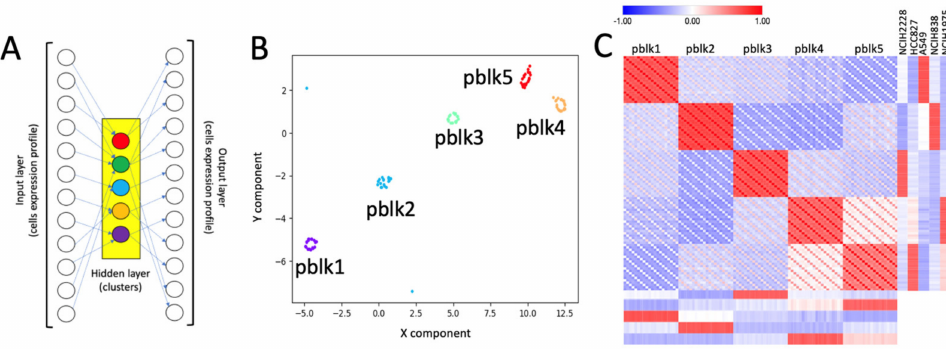
Figure 1. Pseudo-bulk clusters generated by SCA. ( A ) Structure of the SCA used to generate pseudo-bulk RNAseq data from each sub-population (cluster), depicted by clustering of RNA-5c dataset, Figure 2A. The pseudo-bulks are generated using the hidden layer data, repeating multiple times the SCA runs. ( B ) t-Sne output of 20 runs of SCA. It is notable that multiple runs of SCA produce pseudo-bulks, which are clustering around the centroid of each cells’ sub-population, i.e., the circular/oval structures observable in the tSne plot for the 20 runs of SCA. ( C ) Row-mean centered CPM (counts per million of reads) expression for pseudo-bulks ( B ) is combined with row-mean centered TPM (transcripts per million of reads) expression of the bulk RNAseq for H2228, H1975, A549, H838 and HCC827 cell lines, retrieved from the CCLE repository [17]. The plot shows the Pearson correlation matrix of the two datasets. It is notable that pseudo bulk expression correlates with the RNAseq bulk experiment for the five cell lines present in the RNA-5c